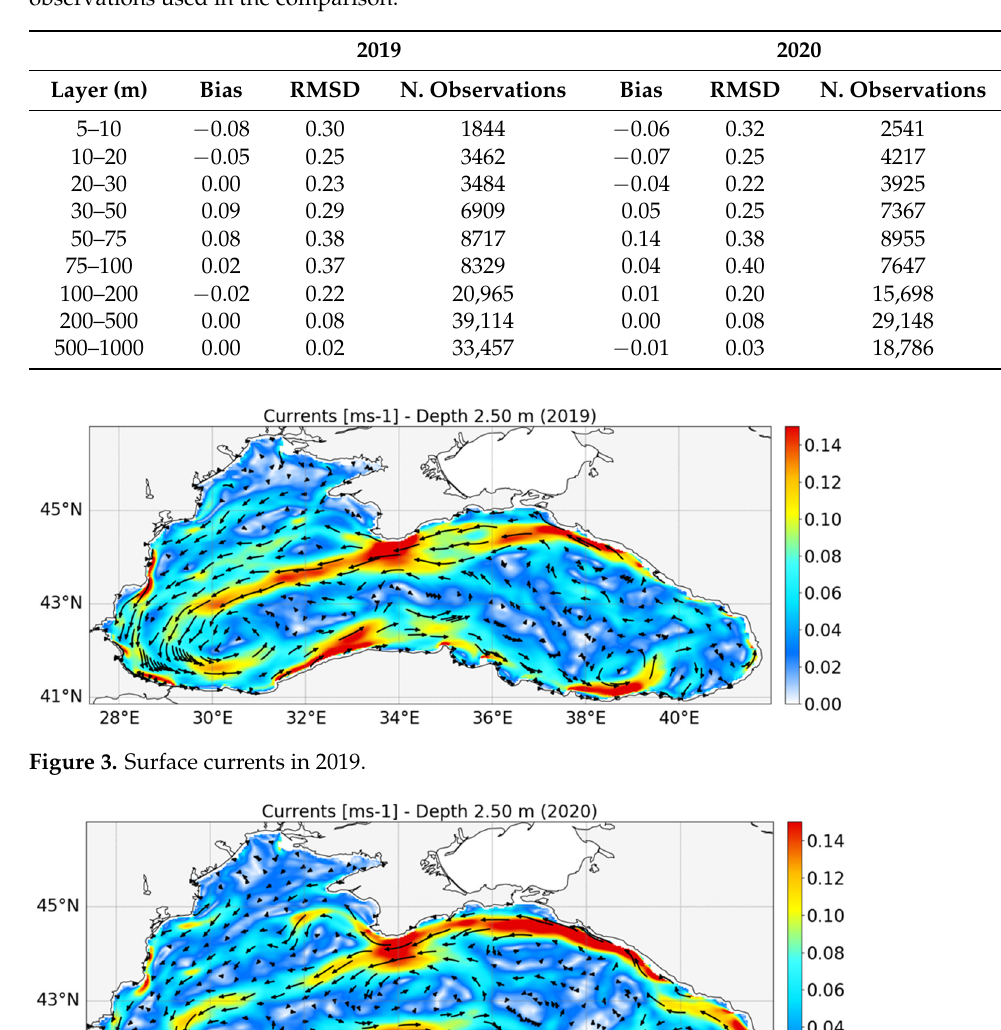
Table 3. EANs for salinity (PSU) in terms of bias and RMSD for 2019–2020, including number of observations used in the comparison.